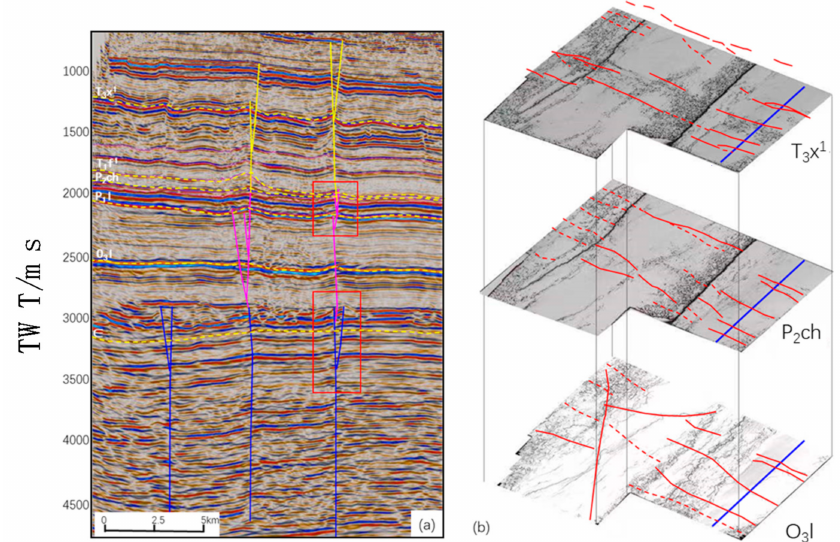
Figure 3. Typical seismic section showing three layered fault zones (( a ); the blue, pink, and yellow lines showing the strike-slip faults in different layers; TWT: two-way travel time of seismic wave and different fault assemblages in different layers) and the strike-slip faults in three layers (( b ); the red lines showing the strike-slip faults; the blue line showing the location of Figure 3a). T 3 x 1 : the Upper Triassic Xujiahe Formation; P 2 ch: the upper Permian Changxing Formation; O 3 l: the Upper